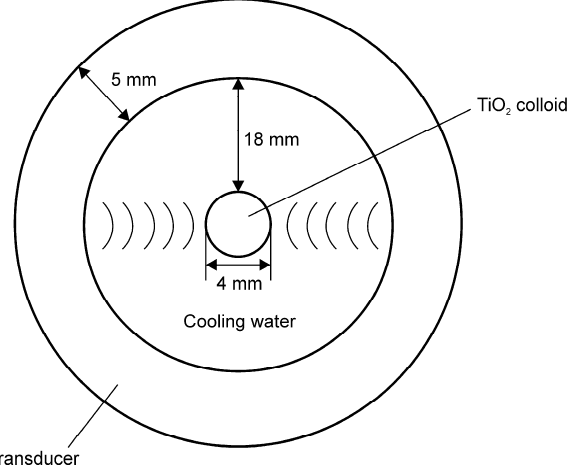
Figure 2. Aerial cross-sectional view of the ultrasonic dispersion equipment and the dimensions of the focused ultrasonic field.